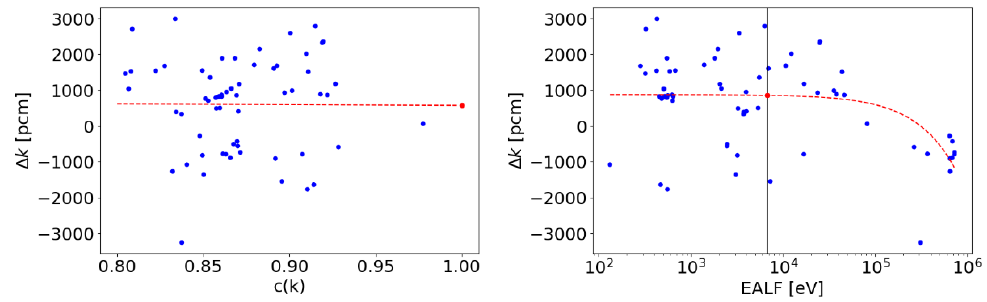
Figures 1e and 1f. The updated error between the model and the corresponding experiment as a function of c